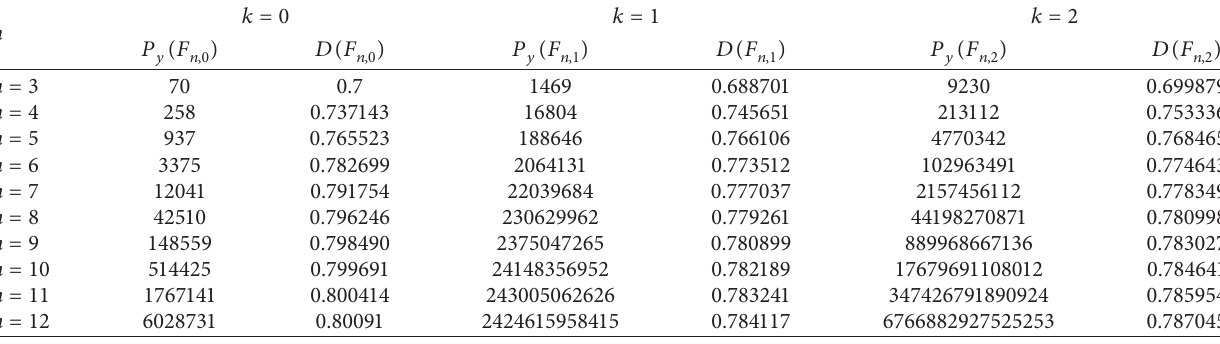
Table 5: Related data for F